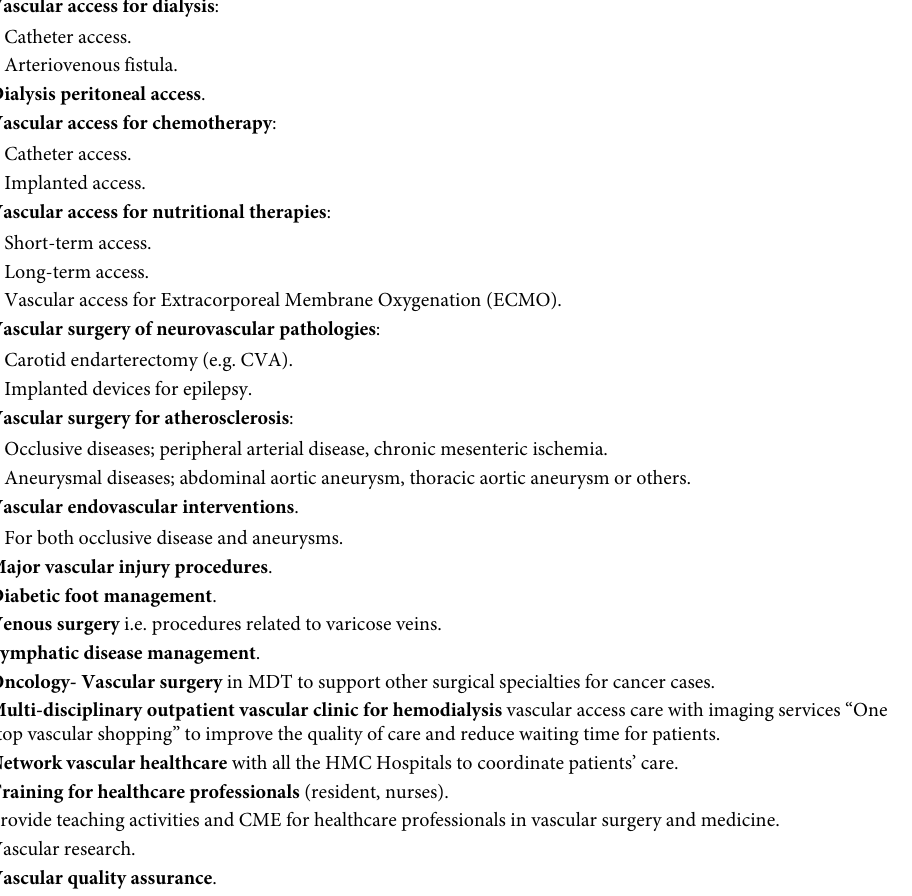
Table 1. Key vascular services at Hamad General